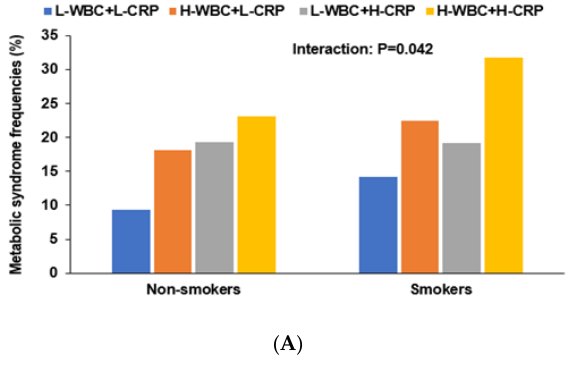
tion with immunity (Table 5).